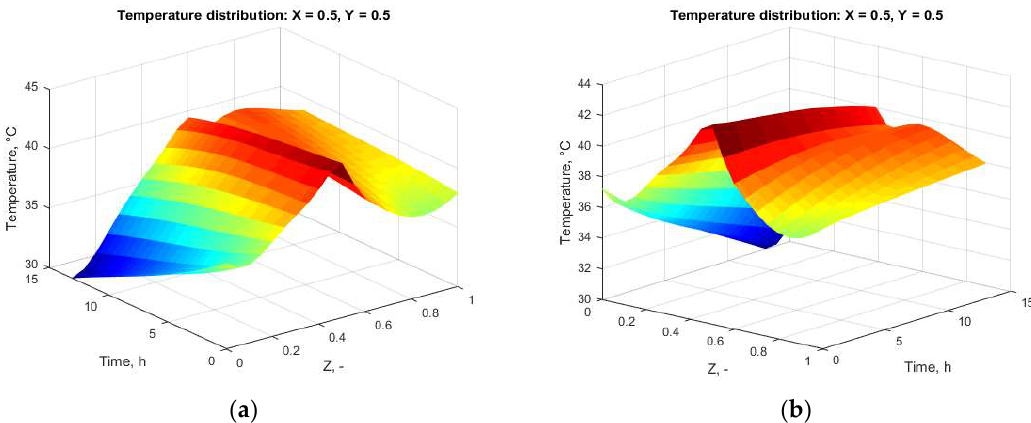
Figure 7. Temperature distribution in dimensionless function of deposit height and time for definite dimensionless values X = 0 and Y = 0 (according to Figure 3) obtained from the model MLP 4-10-1 network.